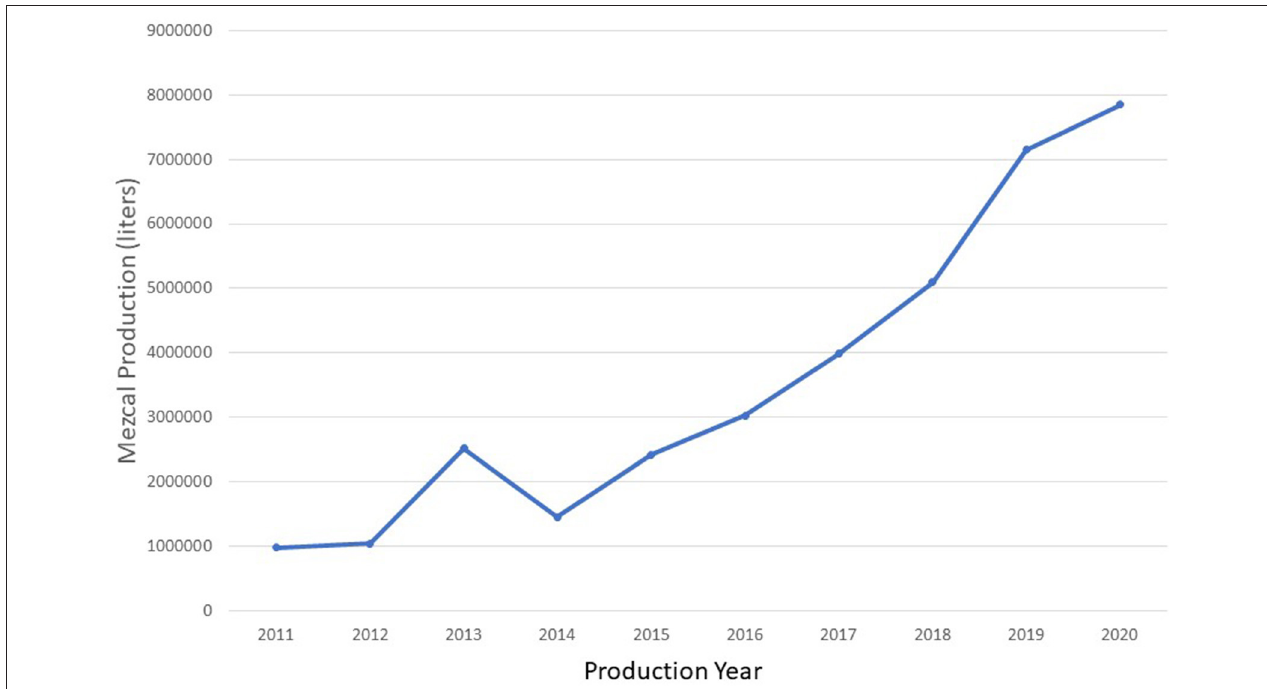
FIGURE 2 | Evolution of mezcal production between 2011 and 2020. Official production registered and certified by the mezcal regulatory council (COMERCAM, 2020).